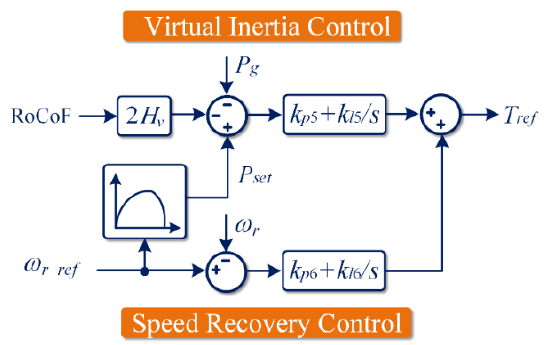
Figure 11. Control block diagrams for virtual inertia and speed recovery.